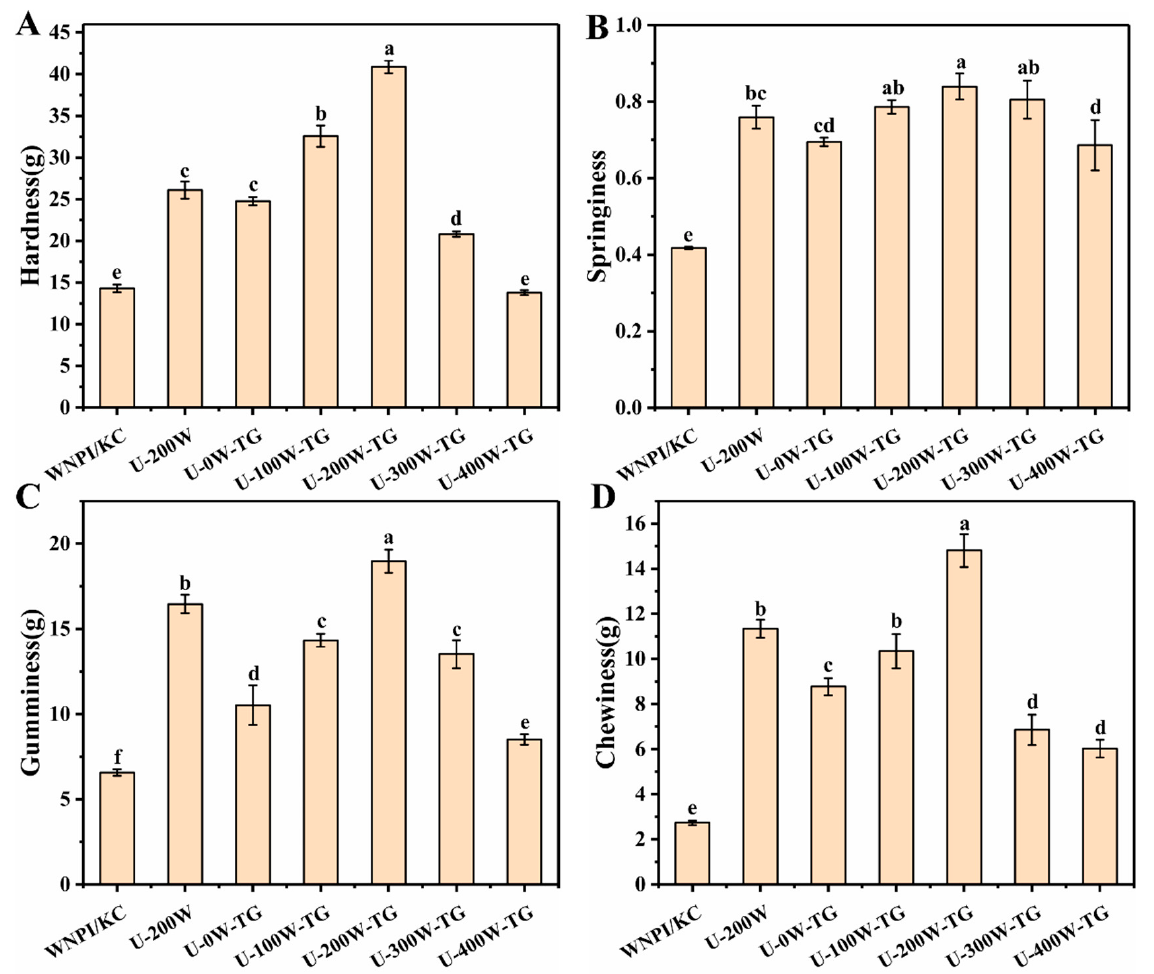
Figure 2. Effects of ultrasonic power on texture properties of WNPI-KC composite gels. ( A ) Hardness; ( B ) Springiness; ( C ) Gumminess; ( D ) Chewiness. Different letters on the bars indicate significant differences ( p <